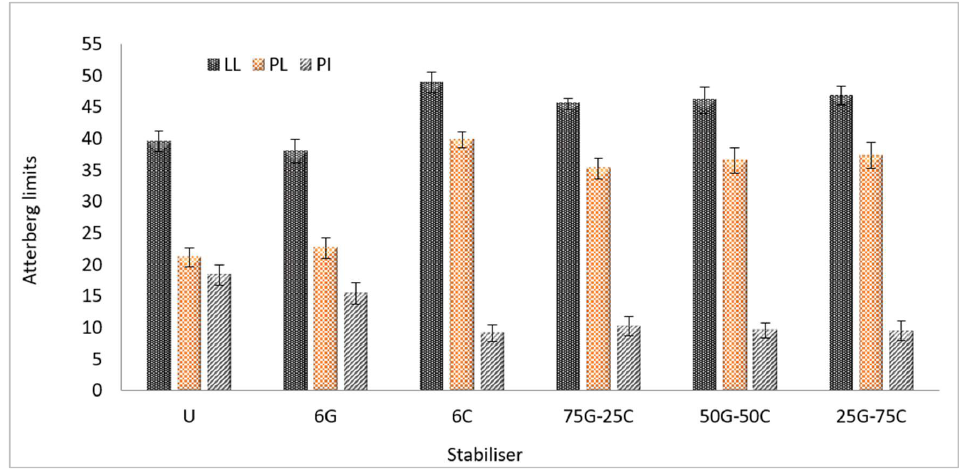
Figure 4. Atterberg limit (LL, PL, PI) results.